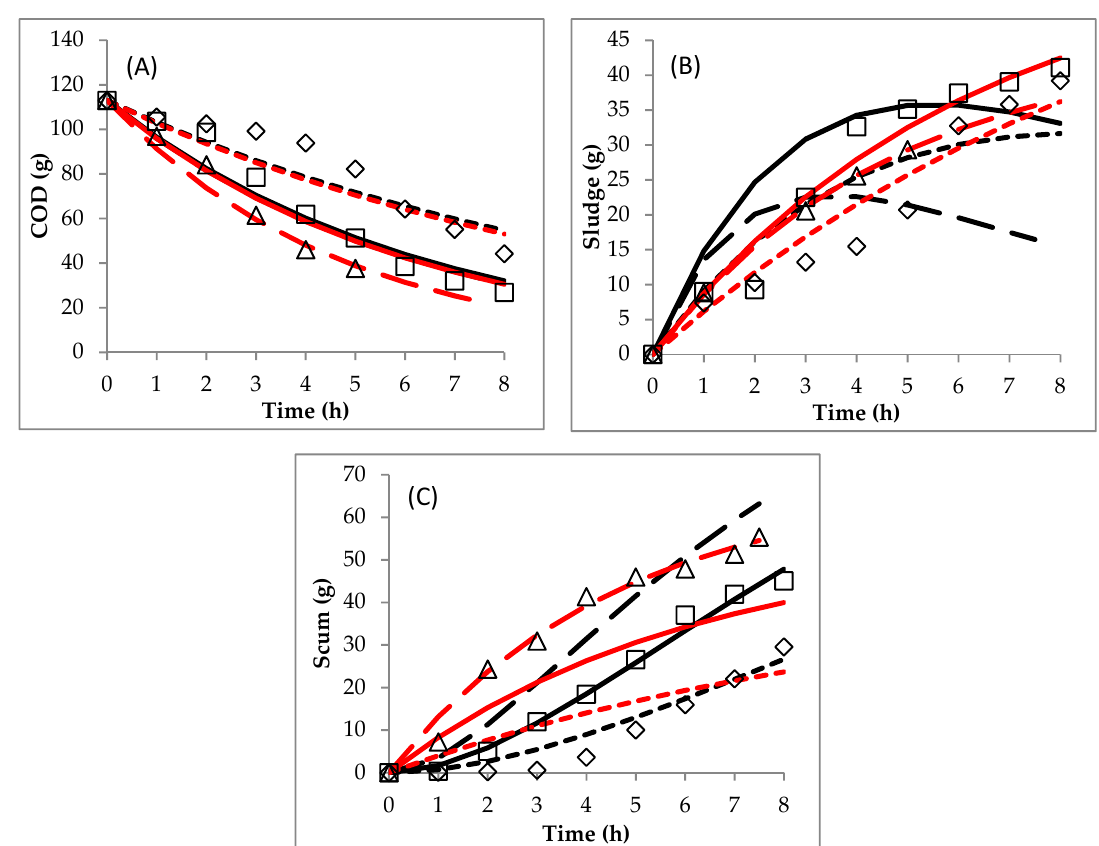
Figure 8. Comparison between experimental data and predicted data obtained by the mechanistic models: ( A ) COD, ( B ) sludge and ( C ) scum. ( ◊ , initial pH 4.4 experimental data; □ , initial pH 5 experimental data; ∆ , initial pH 7 experimental data), (black line-square dot, initial pH 4.4 model 1; black line-solid, initial pH 5 model 1; black line-long dash, initial pH 7 model 1) and (red line-square dot, initial pH 4.4 model 2; red line-solid, initial pH 5 model 2; red line-long dash, initial pH 7 model 2).